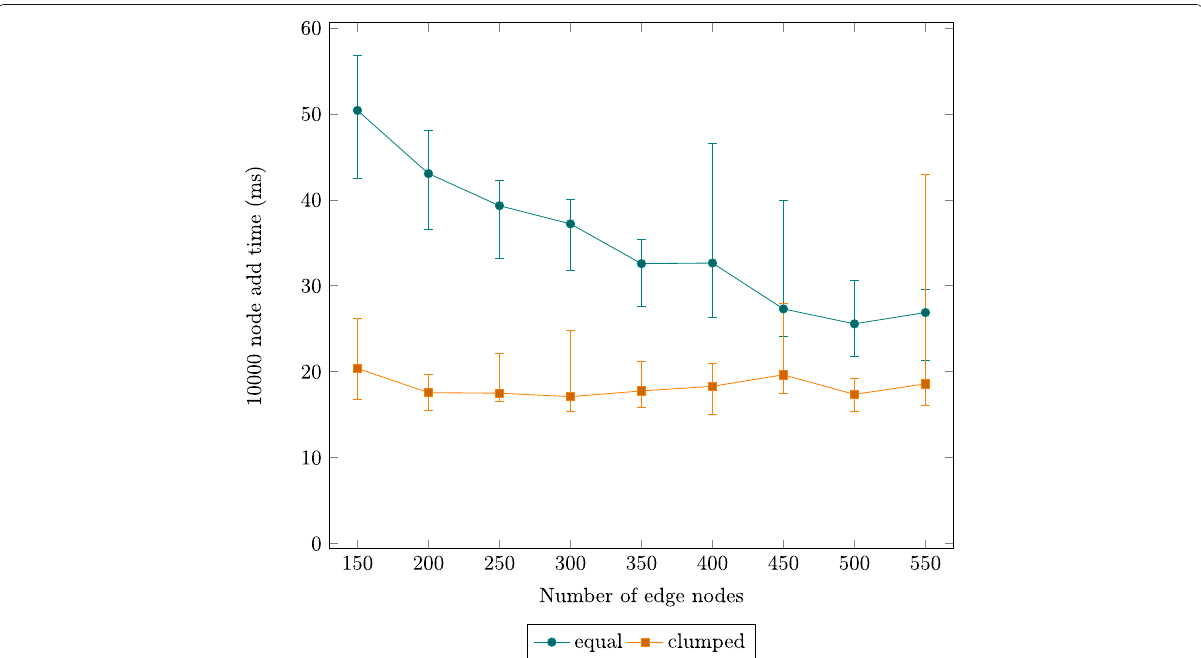
Fig. 10 Effect of equal distribution of edge nodes versus clustered edge nodes in a topology with 100.000 edge nodes. In the clustered series, edge nodes are distributed over 4 equally sized circles at the corners of the